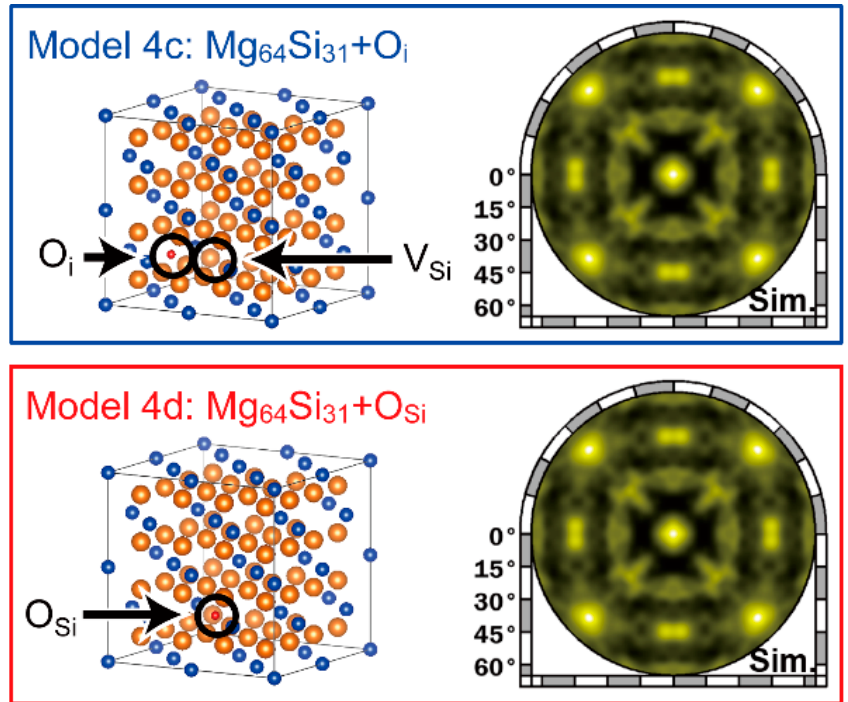
Figure 6. Simulated holograms of Model 4c (Mg 64 Si 31 + O i ) and Model 4d (Mg 64 Si 31 +O Si ).